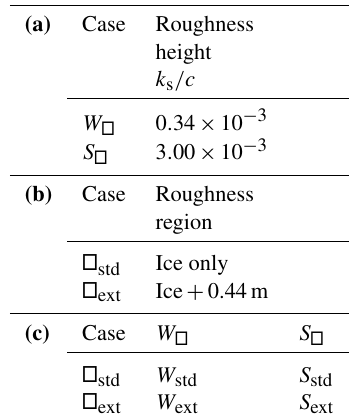
Table 3. Roughness heights (a) and regions (b) tested, as well as the resulting test matrix (c)